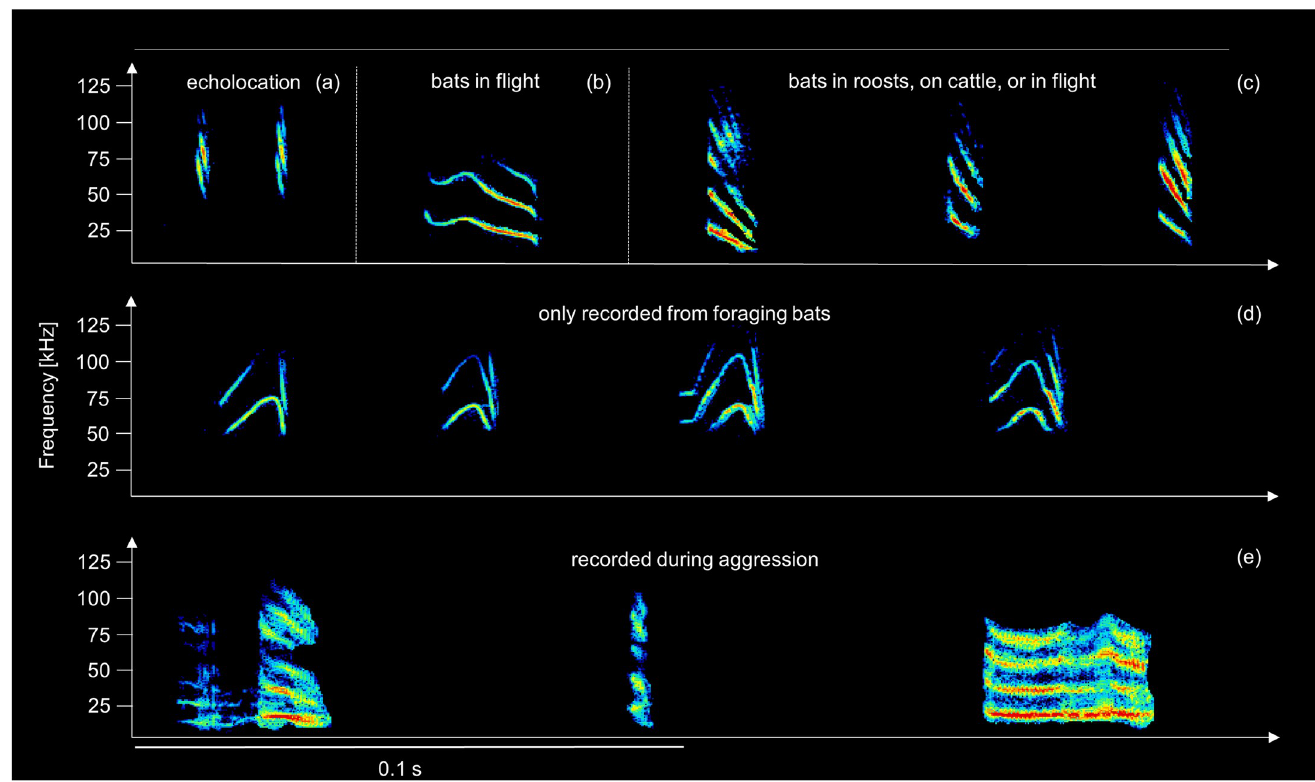
Fig 3. Spectrograms of social calls of common vampire bats flying near or attacking free-ranging cattle on a pasture. Behavioral context was derived from synchronized video, and we identified the calling bat when mouth movements were visible. Calls include (a) echolocation calls (biosonar), (b) undulated down sweep, which was only observed in one recording where 2 bats where flying near a cow, (c) down sweep calls, (d) n-shaped calls, and (e) buzz calls recorded while 2 bats engaged in antagonistic behavior on a single cow. Inter-call intervals were modified for the figure, except for the call sequence in panel (e), a sequence recorded from 2 aggressively interacting